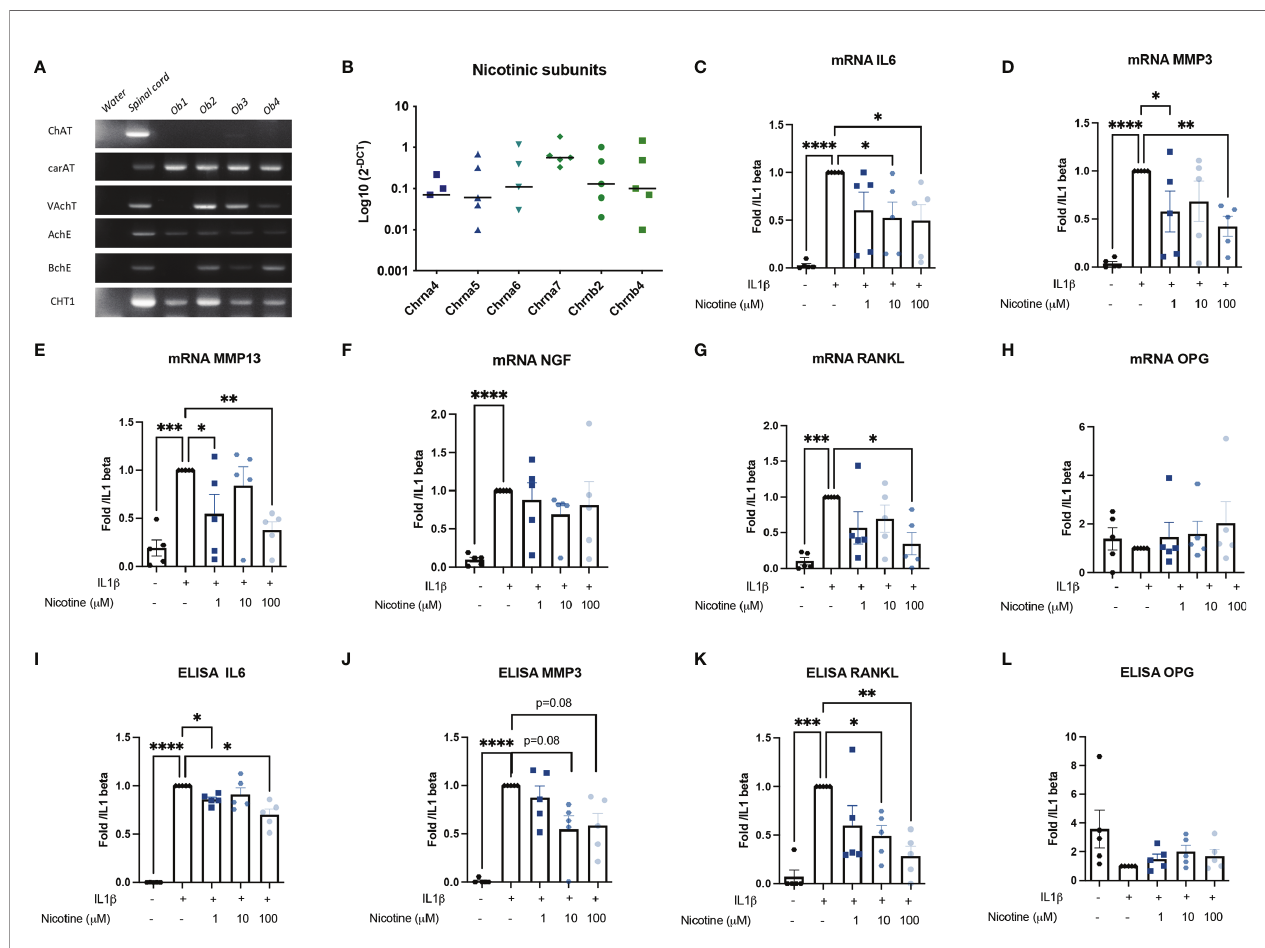
FIGURE 1 | Murine OB expressed a cholinergic system and nAchR activation modulate response to in fl ammatory stress. (A) Representative RT-PCR analysis of the cholinergic system expressed by murine OB ( n = 4 from Ob1 to Ob4). Water RNase-free condition is a negative control for each primer while mouse spinal cord mRNA is a positive control. (B) qPCR expression of nAchR subunits ( n = 5). mRNA expression of (C) IL6, (D) MMP3, (E) MMP13, (F) NGF, (G) RANKL, and (H) OPG by WT OB pretreated with 1, 10, or 100 µM nicotine for 15 min and stimulated with 10 ng/ml IL1 b for 24 h ( n = 5 for WT, * p < 0.05 using RM one-way ANOVA with Dunnett post-test). The results are normalized to the IL1 b condition. ELISA results of (I) IL6, (J) MMP3, (K) RANKL, and (L) OPG in WT OB pretreated with 1, 10, or 100 µM nicotine for 15 min and stimulated with 10 ng/ml IL1 b for 24 h ( n = 5 for WT, * p < 0.05 using RM one-way ANOVA with Dunnett post-test). The results are normalized to the IL1 b condition. ChAT, choline acetyltransferase; carAT, carnityl acetyltransferase; VAChT, vesicular acetylcholine transporter; AChE, acetylcholine esterase; BChE, butyrylcholine esterase; CHT1, choline transporter-1; IL6, interleukin-6; MMP3, metalloprotease-3, NGF, nerve growth factor, OPG, osteoprotegerin; RANKL, the receptor activator of nuclear factor kappa-B ligand. *p<0.05, **p<0.01, ***p<0.001,